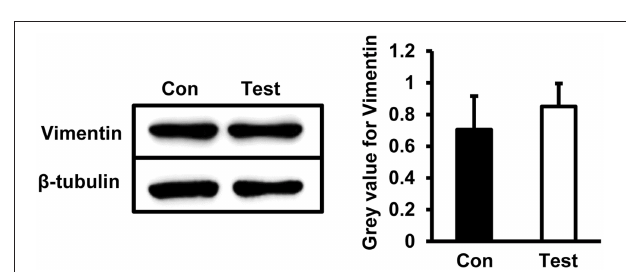
FIGURE 6 | Quantity analysis of Vimentin in HBMVECs. Western blot analysis showed that protein levels of Vimentin was not significantly changed in HEV-infected